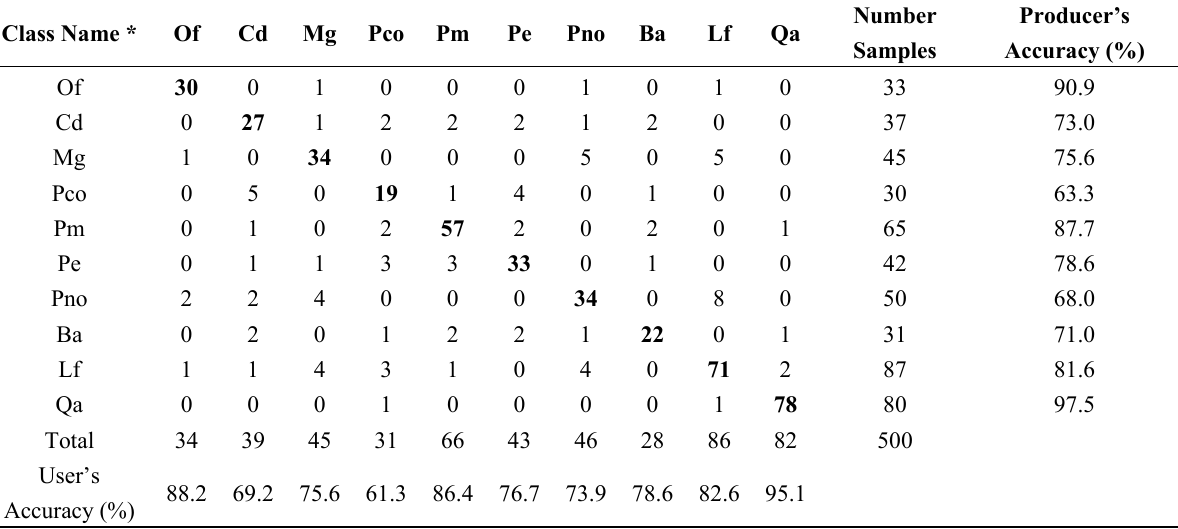
Table 4. Error matrix for the 10 classes classified by the ITC-based classification approach.